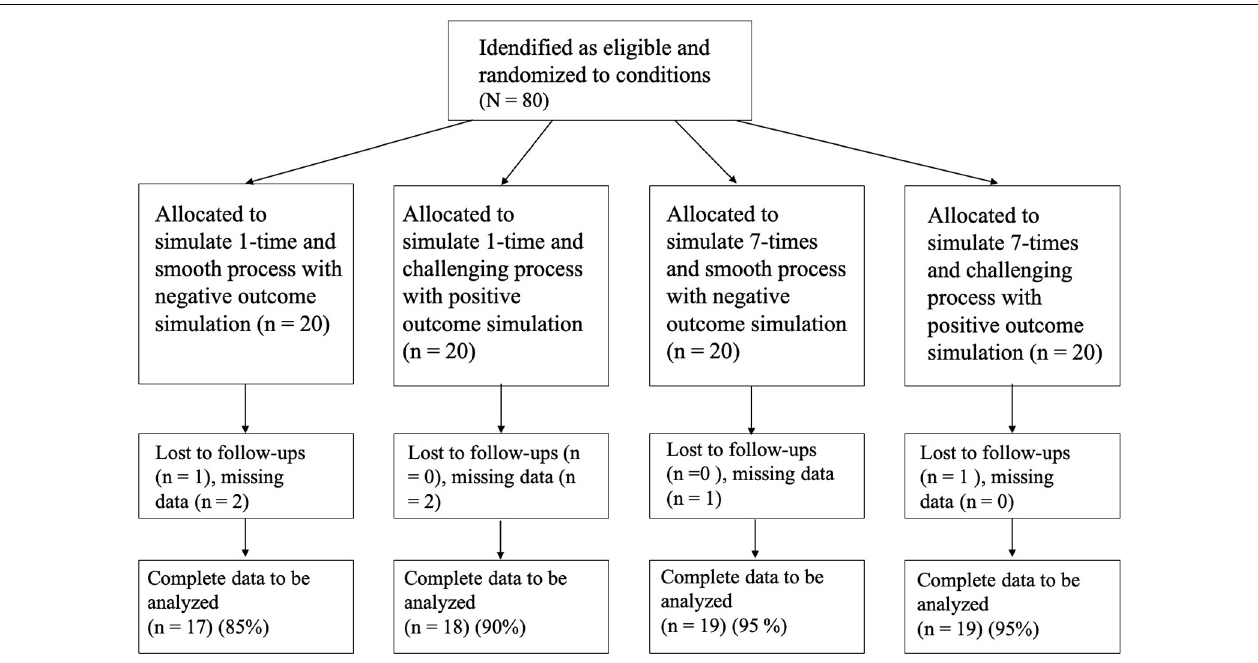
FIGURE 2 | The process of recruiting participants of Study 4.